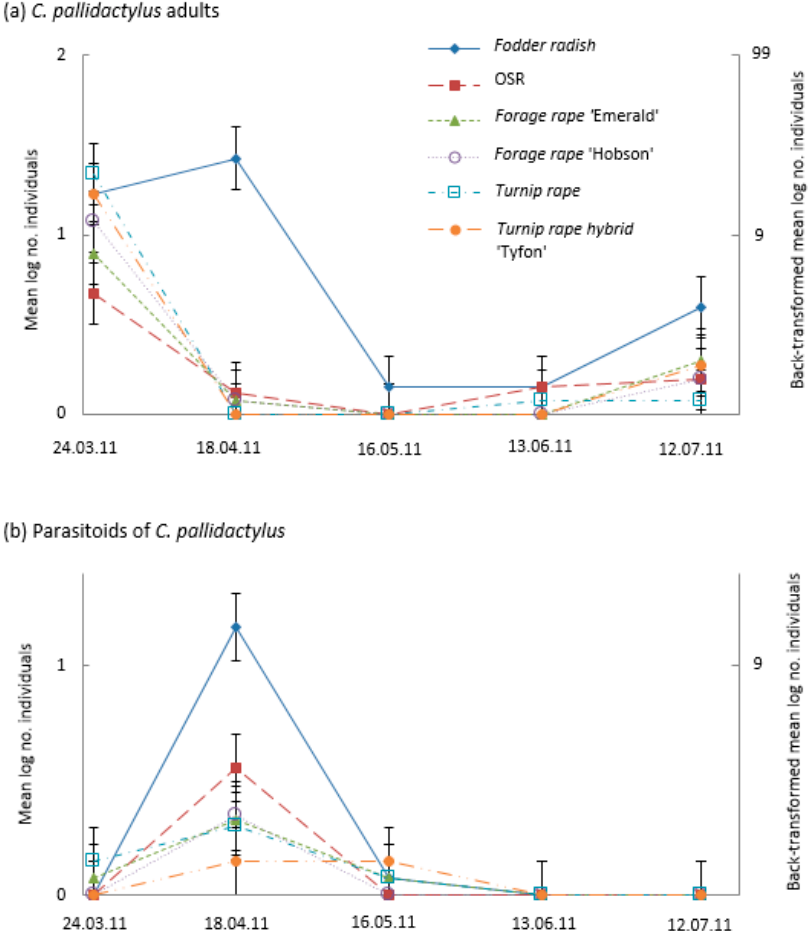
Figure 5. Mean numbers (log scale—left axis and back-transformed right axis) of cabbage stem weevil ( Ceutorhynchus pallidactylus ) ( a ) adults and ( b ) parasitoids in suction samples taken monthly from plots ( n = 4) of different Brassicaceae: Fodder radish ( Raphanus sativus ) cv Apoll; Oilseed rape (OSR; Brassica napus ) cv Castille; Forage rape ( Brassica napus ) cv Emerald and cv Hobson; Turnip rape ( Brassica rapa ) cv Jupiter and Tyfon (a hybrid of B. rapa Rapifer group × B. rapa Pekinensis group). CIs (vertical bars) are valid for within-date comparisons; for between-date comparisons, CIs should be based on SEM values of ( a ) 0.0806 and ( b ) 0.0723.